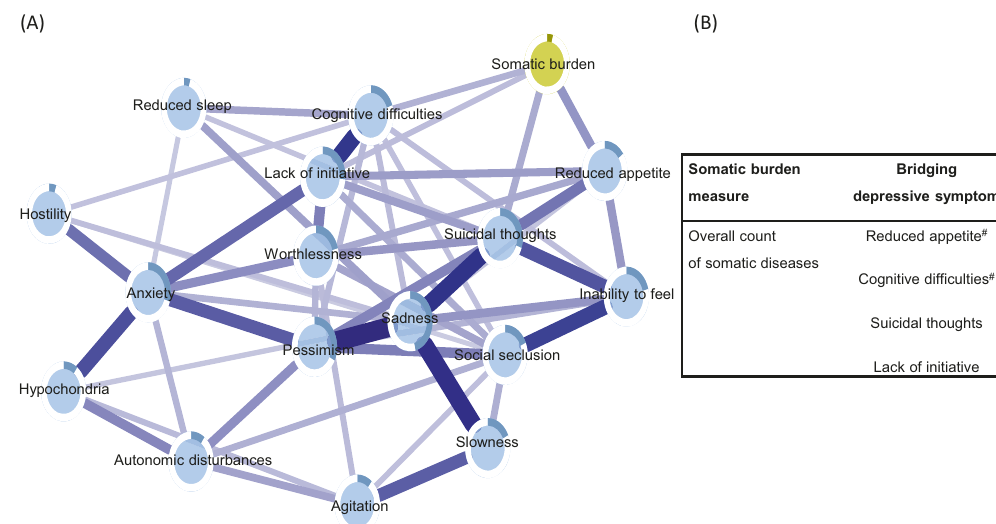
Fig. 4 Network of depressive symptoms with a node for overall somatic burden (panel A ). Blue connections indicate positive correlations; the thickness of lines is proportional to the strength of the correlation. The darker outer circle of each node represents the predictability, i.e., the proportion of the variance in a node explained by its neighbouring nodes. The table (panel B ) reports bridge connections between the overall somatic burden and depressive symptoms. # Bridge connection preserved after including nodes for age, sex, and